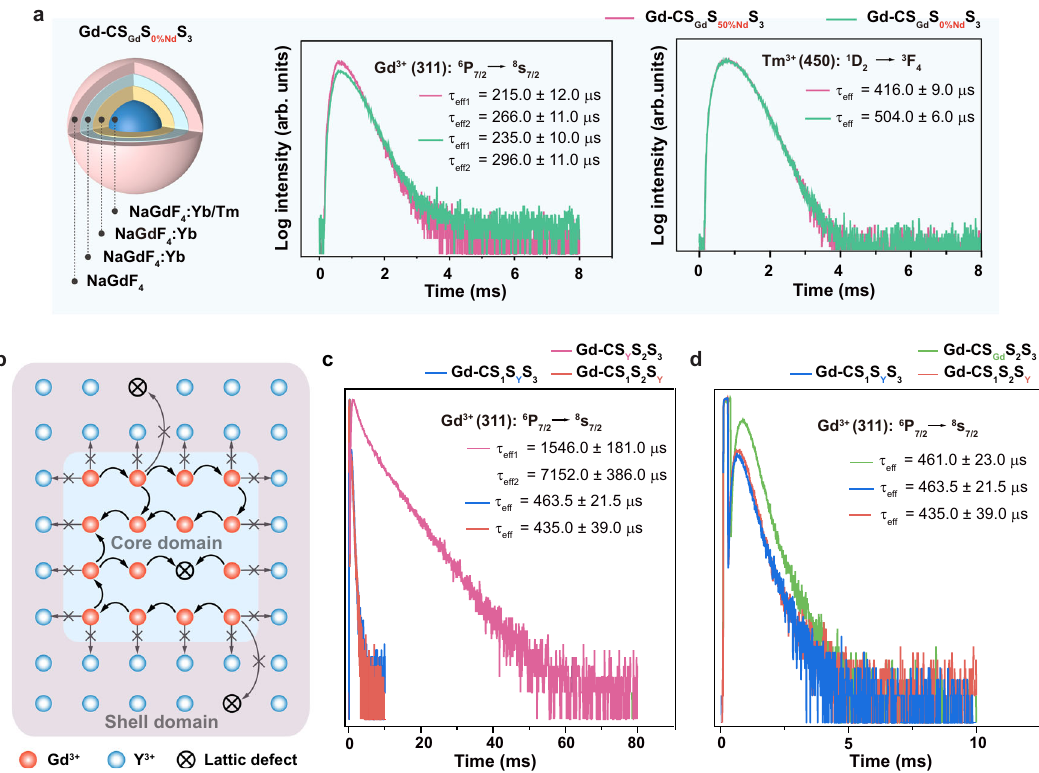
Fig. 7 Mechanistic investigation of Gd 3 + energy recycling to avoid the interior traps in the heterogeneous core-shell nanoparticle. a Schematic illustration of the as-synthesized Gd-CS Gd S 0%Nd S 3 nanoparticles, and the upconversion luminescence decay curves of Gd 3 + emission at 311 nm and Tm 3 + emission at 450 nm of Gd-CS Gd S 50%Nd S 3 and Gd-CS Gd S 0%Nd S 3 nanoparticles under 980 nm excitation, respectively. b Schematic illustration of energy recycling in Gd 3 + sublattice at the core domain of NaGdF 4 :Yb,Tm. c The upconversion luminescence decay curves of Gd 3 + emission at 311 nm in